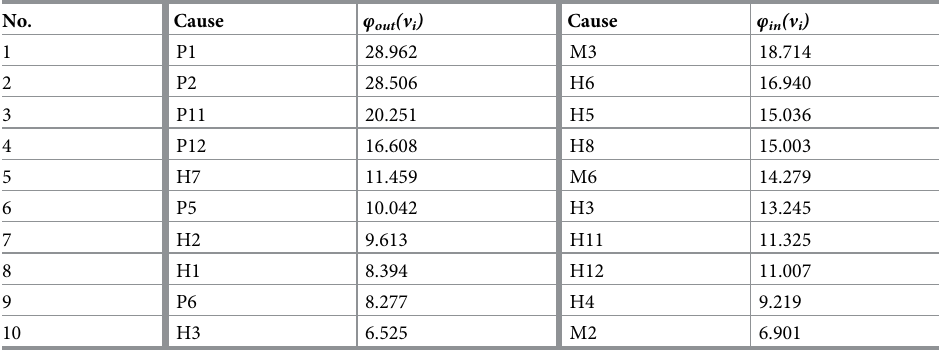
Table 2. The top 10 of network out-degree and in-degree topological potential of lifting injury accidents.